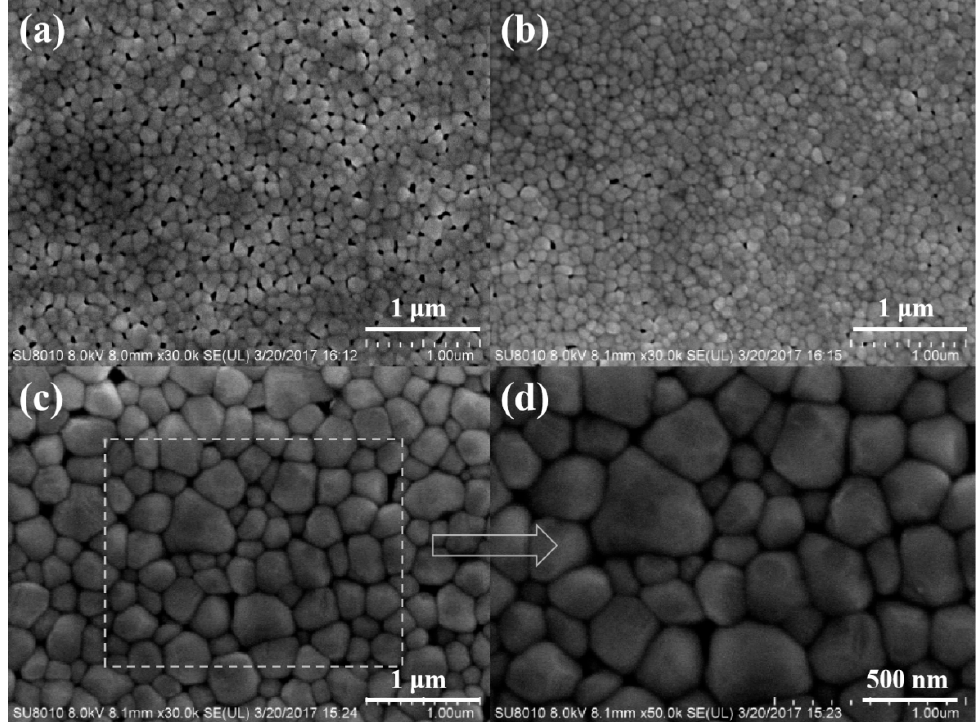
Figure 3. Surface morphologies of BFO thin films annealed at various temperature in an air atmosphere: ( a ) 450 °C ; ( b ) 500 °C ; ( c ) 550 °C ; ( d ) 550 °C .